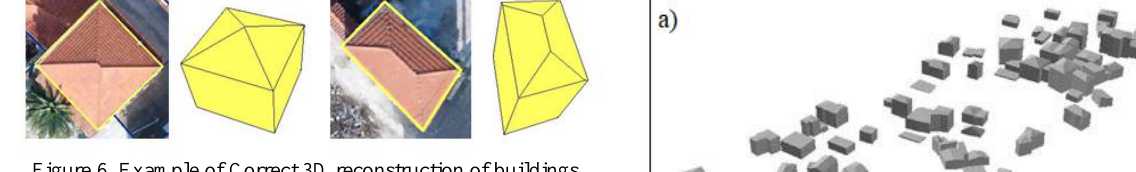
Figure 6. Example of Correct 3D reconstruction of buildings